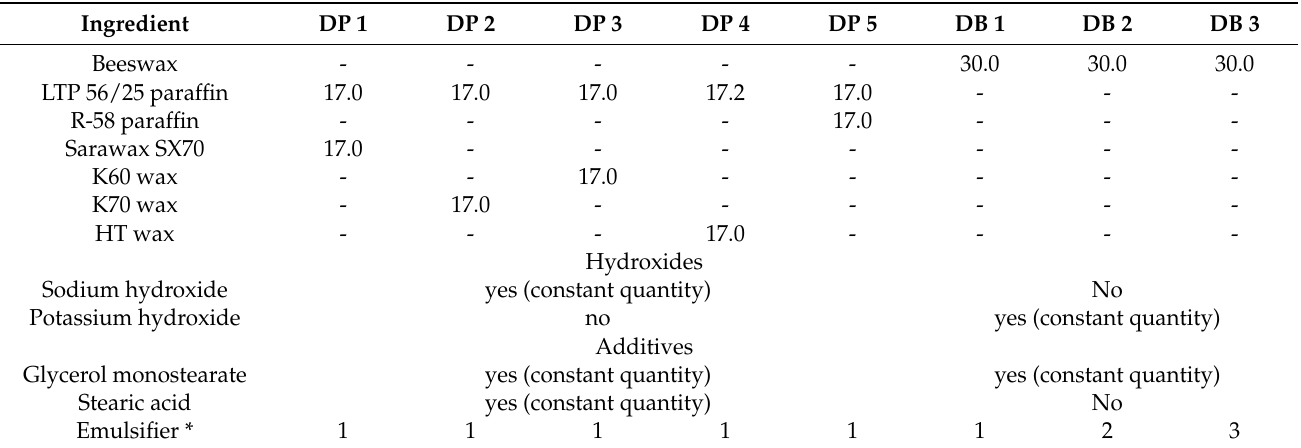
Table 2. Composition of obtained dispersions. Quantity by wt%. DP—paraffin-based dispersions, DB—beeswax-based dispersions.